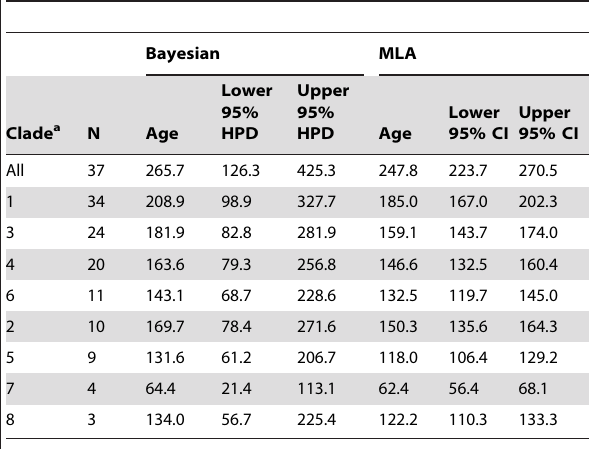
Table 1. Age estimates (Ma) of all strains and the major clades of